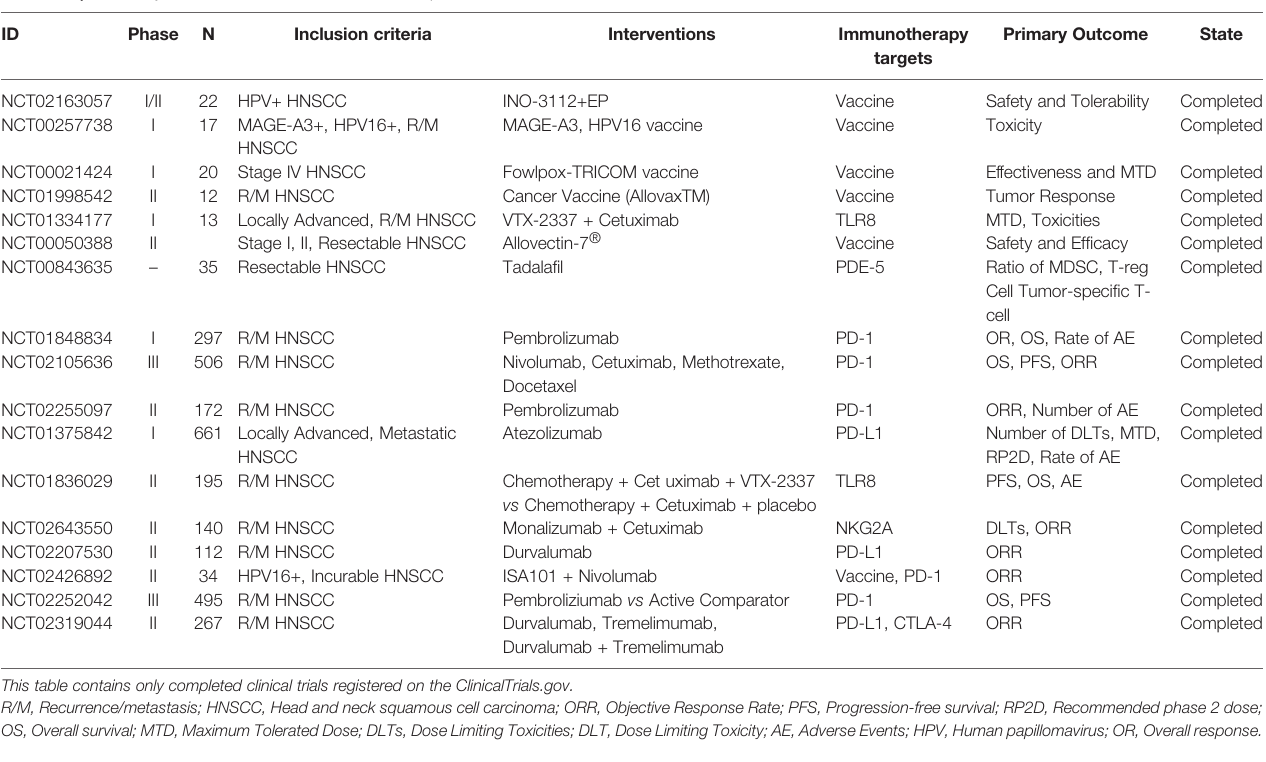
TABLE 2 | Summary of clinical trials that have been